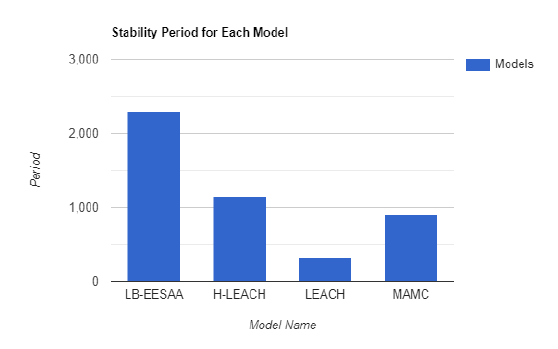
Figure 5. Stability